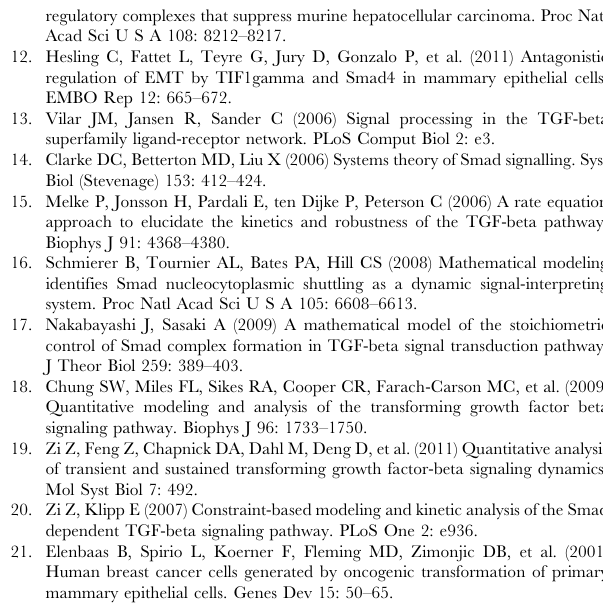
Figure S3 TIF1 c does not affect short-term and switch-